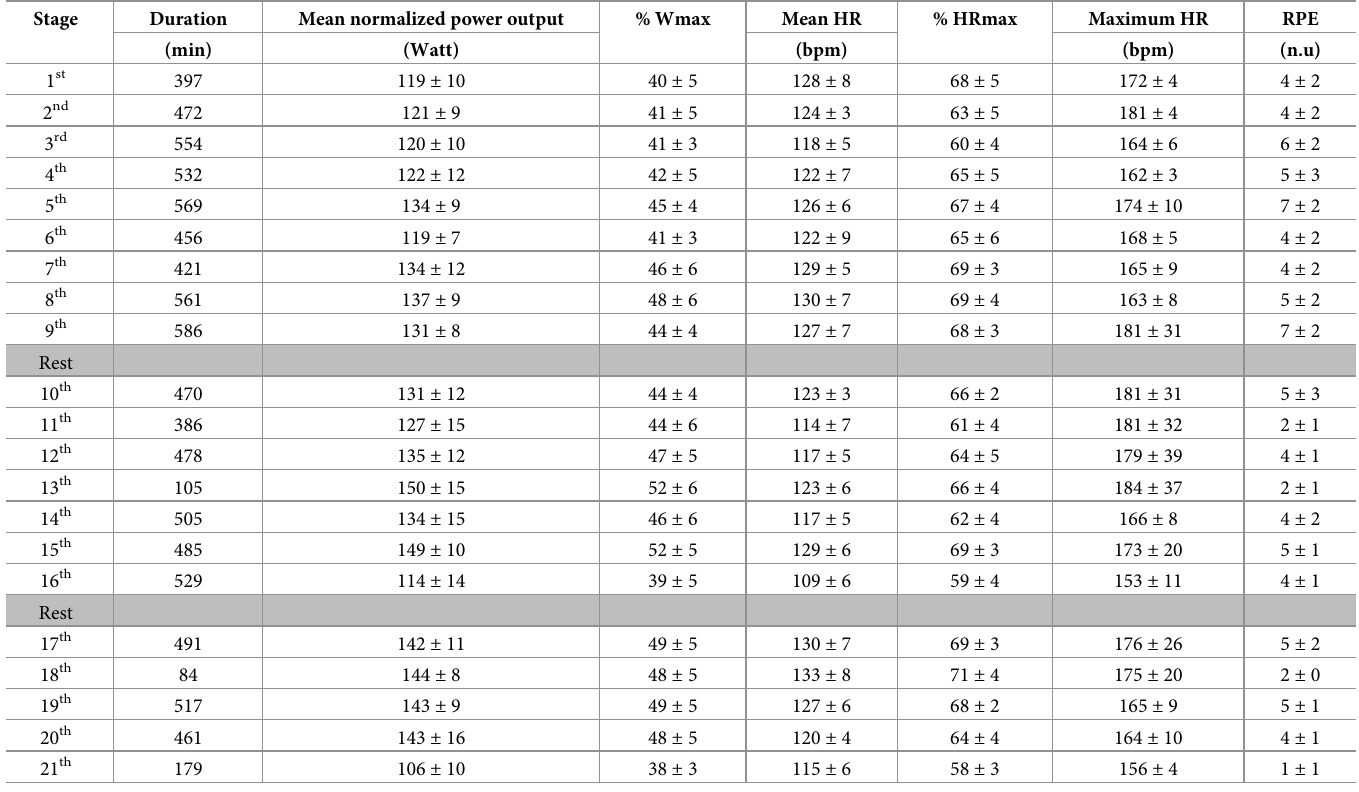
Table 3. Stage-associated exercise